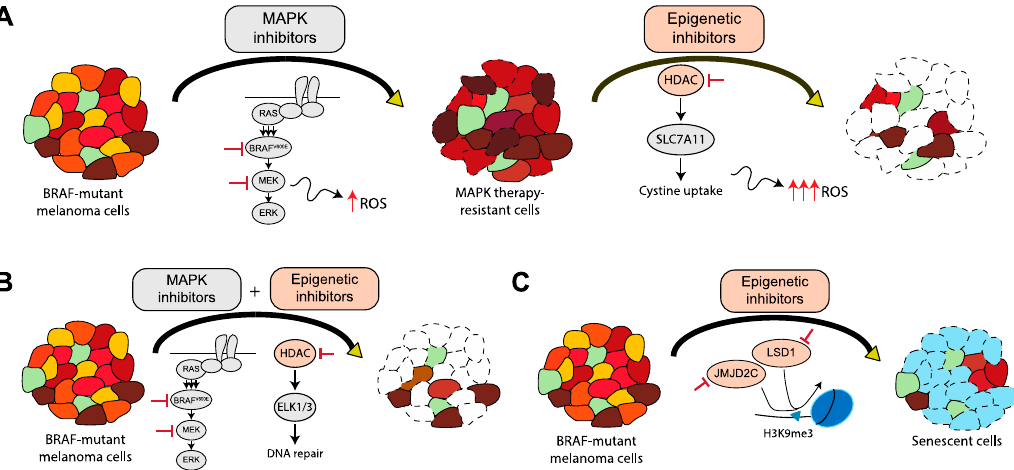
Figure 2. Strategies to target epigenetic mechanisms of drug resistance in BRAF-mutant melanoma cells. ( A ) BRAF-mutant melanoma cells with acquired resistance to MAPK inhibitor therapy are vulnerable to HDAC inhibitors, which suppress the transporter, SLC7A11, and increase reactive oxygen species (ROS) to lethal levels, causing apoptosis. ( B ) Treatment with a combination of MAPK and HDAC inhibitors is effective in inducing apoptosis in BRAF-mutant melanoma cells. The combination treatment reduces ELK1 and ELK3 levels, resulting in aberrant activity of DNA repair mechanisms and subsequent melanoma cell death. ( C ) Treatment of BRAF-mutant melanoma cells with LSD1 or JMJD2C inhibitors reduces melanoma cell growth and restores oncogene-induced senescence.